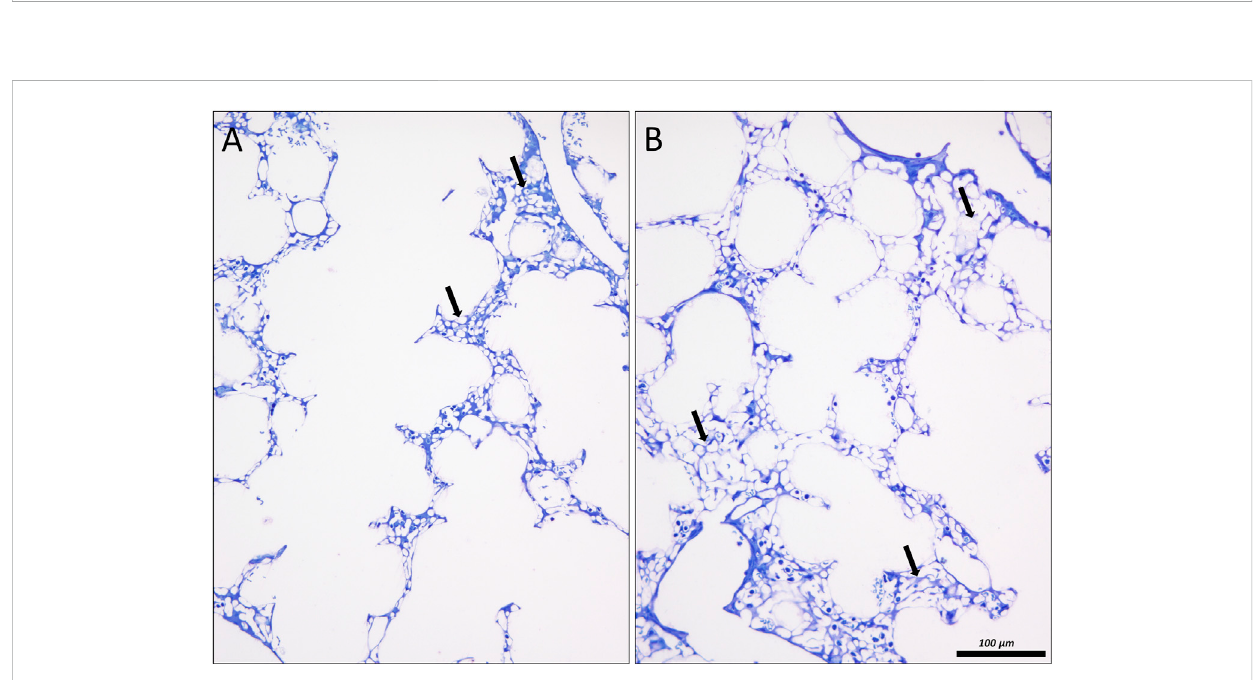
FIGURE 11 Lung injury and microatelectases: In (A) an image of the lung of a surfactant protein B knock out mouse is shown, fi xed in situ by vascular perfusion via the right ventricle at an airway opening pressure of 10 cmH 2 O on expiration two recruitment maneuvers (3 s pause at 30 cmH 2 O) (Ruhl et al., 2019). The alveolar ducts are enlarged. Alveolar airspaces are rare and appear to be shallow. Instead, microatelectases (arrows) can be identi fi ed as seemingly thickened interalveolar septa characterized by a conglomeration of capillaries. In (B) similar fi ndings can be observed in a rat lung 1 day after instillation of bleomycin to induce lung injury. The lung was fi xed in vivo by vascular perfusion via the vena cava caudalis atan airway opening pressure of 10